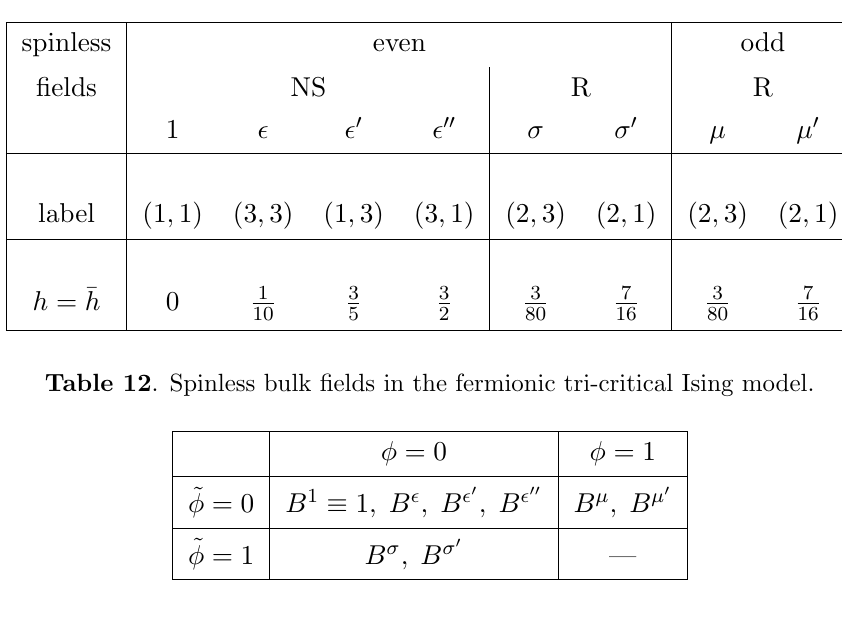
Table 13 . The bi-grading of the generators of the tri-critical Ising model boundary classifying